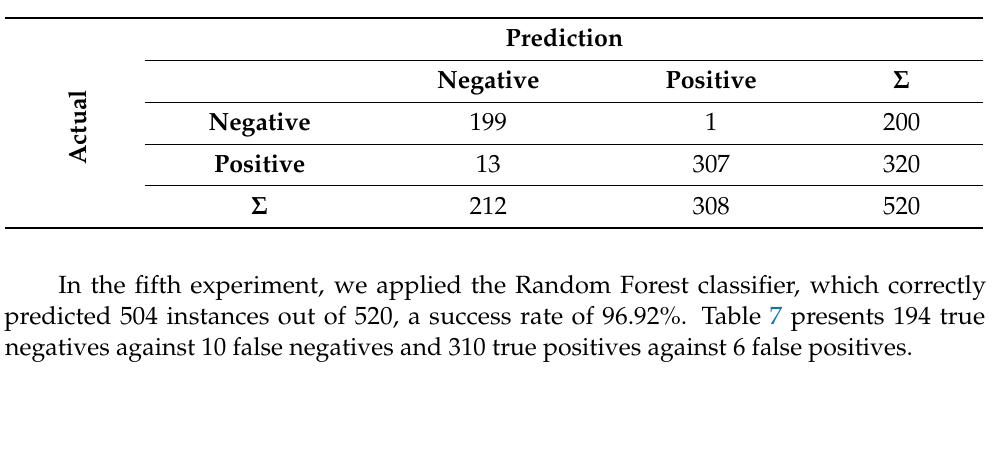
Table 6. Confusion Matrix of kNN